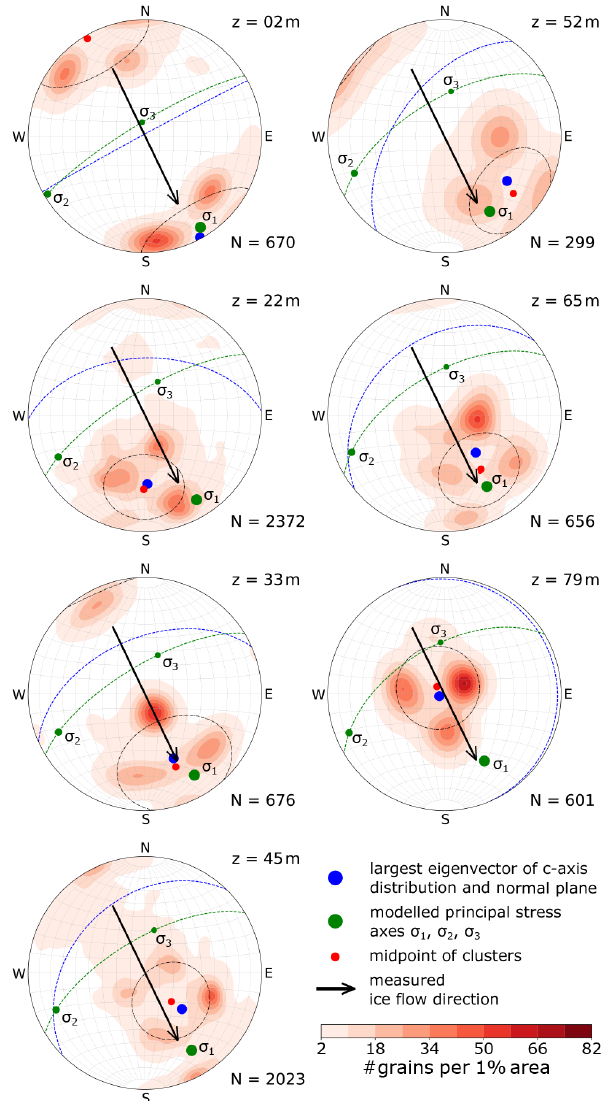
Figure 8. Stereo-plots (lower-hemisphere Schmidt equal-area pro- jection) with the colour-coded (same as Fig. 5) c -axis distribution for each sample shown. Note that the azimuth for z = 2m is cor- rected by − 60 ◦ (see text for discussion). The total number of ice grains is specified for each sample. The dashed black line shows the mean opening angle for the cone of maxima around the centroid de- picted as a red dot. The calculated largest eigenvector for the c -axis distribution is shown as a blue dot (its normal plane as a dashed blue line), and the calculated largest compressional principal stress axis from the ice flow model is represented by a green dot (its normal plane as a dashed green